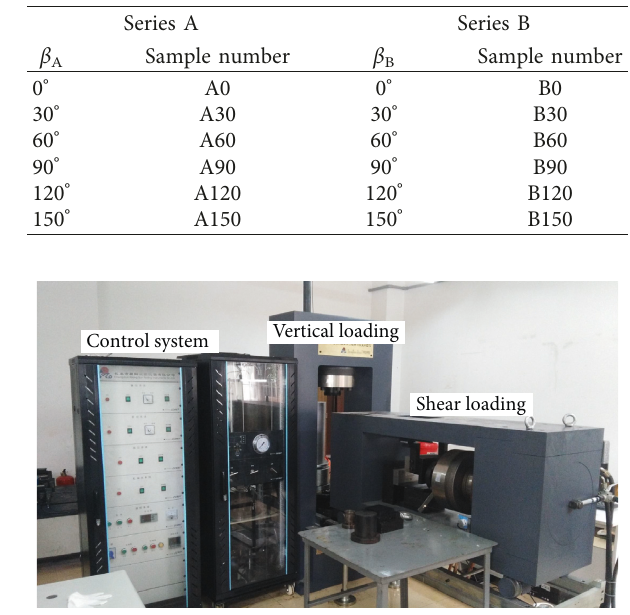
Figure 1: Schematic diagram of the joint configuration for (a) Series A and (b) Series B. Table 1: Joint inclination angle and sample number. Table 2: Microparameters in bonded particle model.